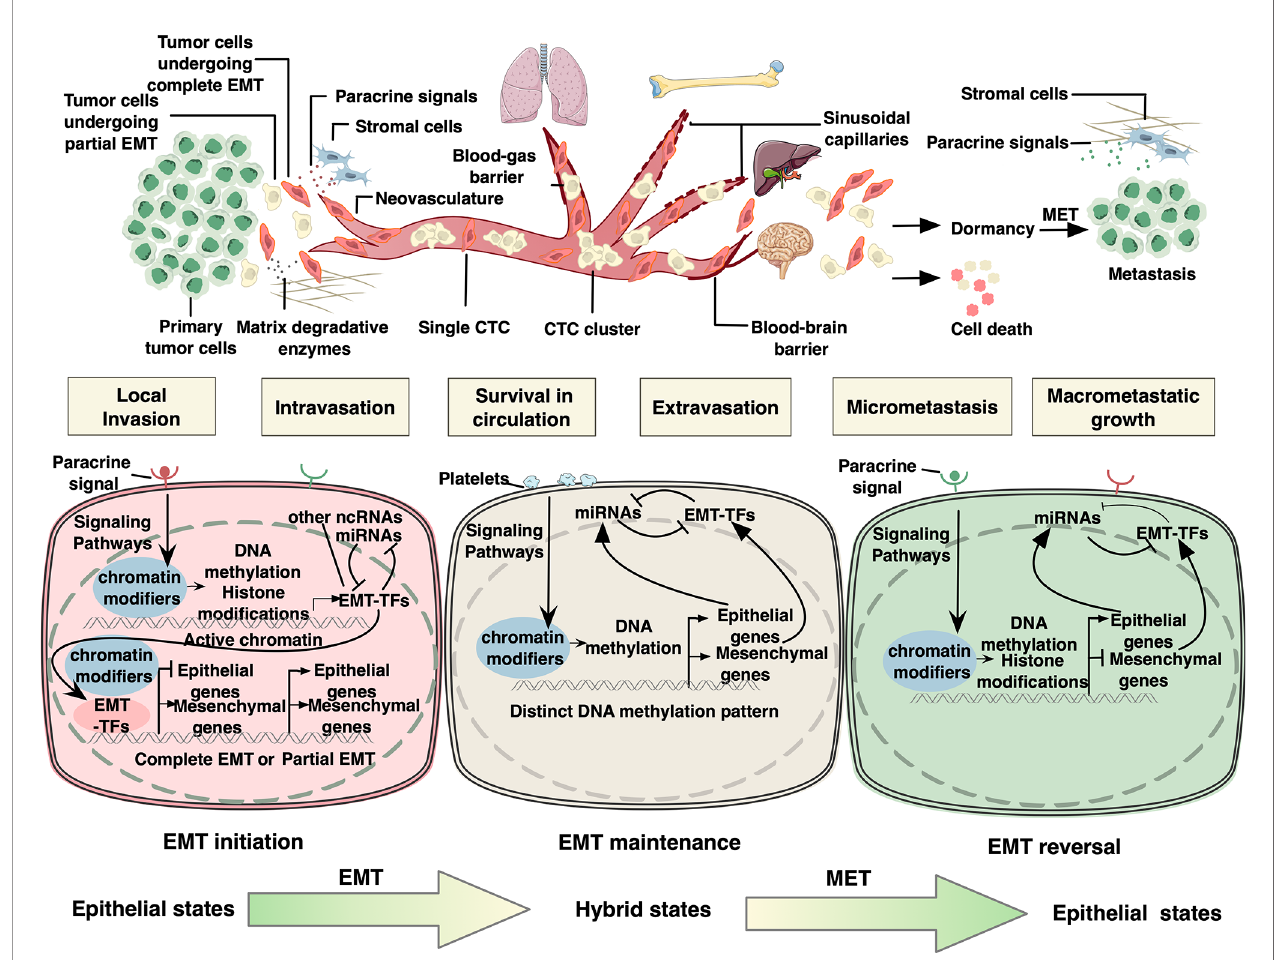
FIGURE 1 | Epigenetic regulation of epithelial to mesenchymal transition in cancer metastatic cascade. In the primary tumor, for local migration, epithelial tumor cells initiate EMT program by activating signaling pathways responsive to speci fi c environmental stimuli. As a result, EMT-related transcription factors (EMT-TFs) are induced, whose expression can be regulated by DNA methylation, histone modi fi cations, and RNA-mediated epigenetic regulation. Next, EMT-TFs collaborate with various epigenetic proteins to regulate the expression of downstream EMT effectors. It is assumed that tumor cells undergo partial EMT instead of complete EMT to improve their metastatic ability. After local migration, tumor cells disseminate into the circulation, known as circulating tumor cells (CTCs). CTCs interact with platelets through different cell surface receptors and ligands, by which they sustain EMT via platelet-derived TGF b signals in the absence of stroma-derived signaling cues that initiated EMT in the microenvironment of the primary lesion. CTC clusters and single CTCs have been demonstrated to exhibit distinct DNA methylation patterns of EMT-associated genes. In addition, members of miR-200 family have been acknowledged as key regulators of EMT maintenance in CTCs by forming double- negative feedback loops with EMT TFs, in which they reciprocally repress each other ’ s translation or transcription. The extravasation mechanisms of CTCs vary widely depending on the fl ow direction and organ-speci fi c vascular structure. Upon reaching the distant sites, the vast majority of carcinoma cells will not survive, while a small minority persist in a quiescence state as dormant cancer cells until reinitiate growth and form colonization. It is proposed that invasive cells need to undergo MET to acquire the capability of macrometastatic growth. MET is mainly triggered and regulated by contextual signals from microenvironment or due to the absence of EMT-inducing signals from the primary tumor microenvironment, resulting in downregulation of several EMT-TFs. The negative feedback loops consisting of pairs of miRNAs and EMT-TFs are also considered the driving force underpinning this state reversibility. Both EMT-TFs and micro RNAs in these loops have also been shown to be elaborately regulated by epigenetic mechanisms including DNA methylation and histone modi fi